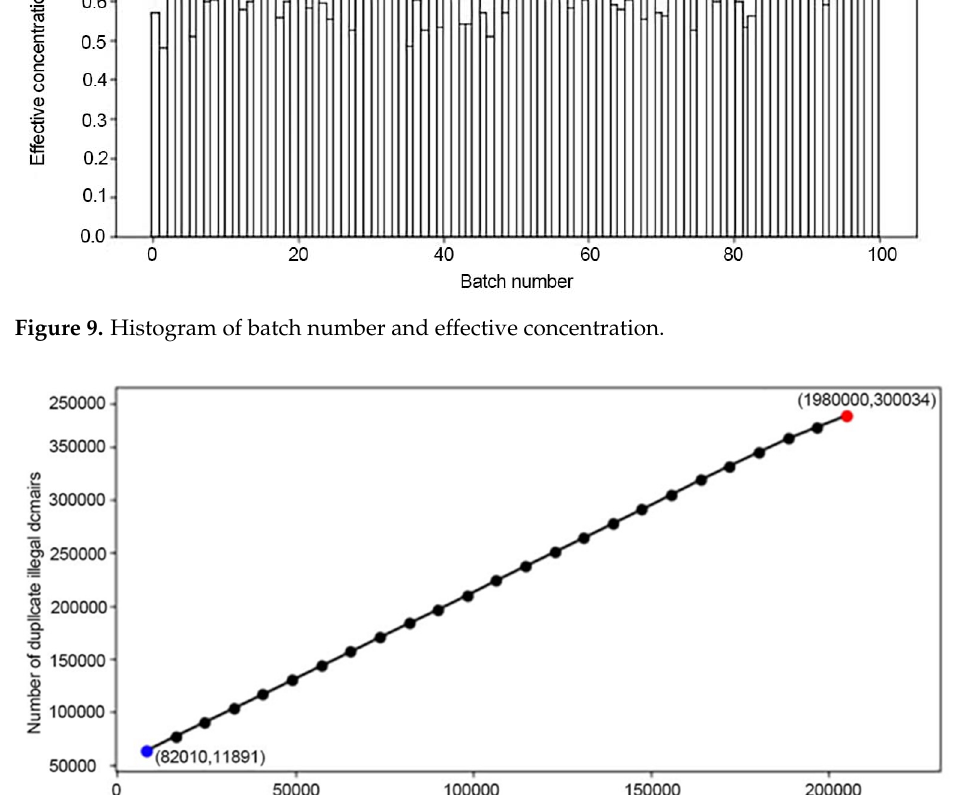
Figure 9. Histogram of batch number and effective concentration.